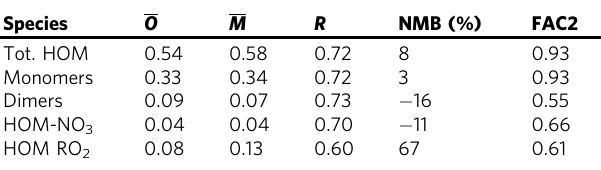
Table 1 Evaluation of the modelled HOM concentrations at the Station for Measuring Ecosystem-Atmosphere Relations II (SMEAR II) Species Tot. HOM